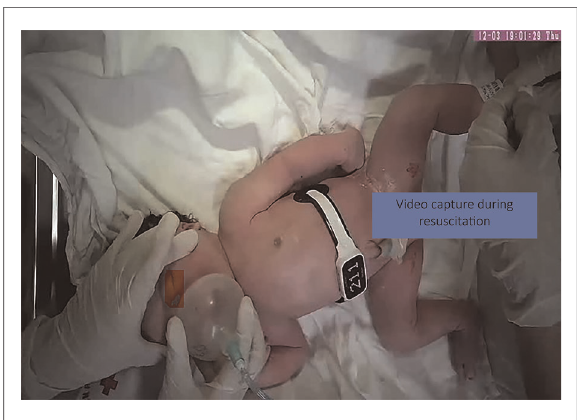
FIGURE 2 A real capture from a video showing the situation at the resuscitation table with NeoBeat on the neonate ’ s chest and only hands